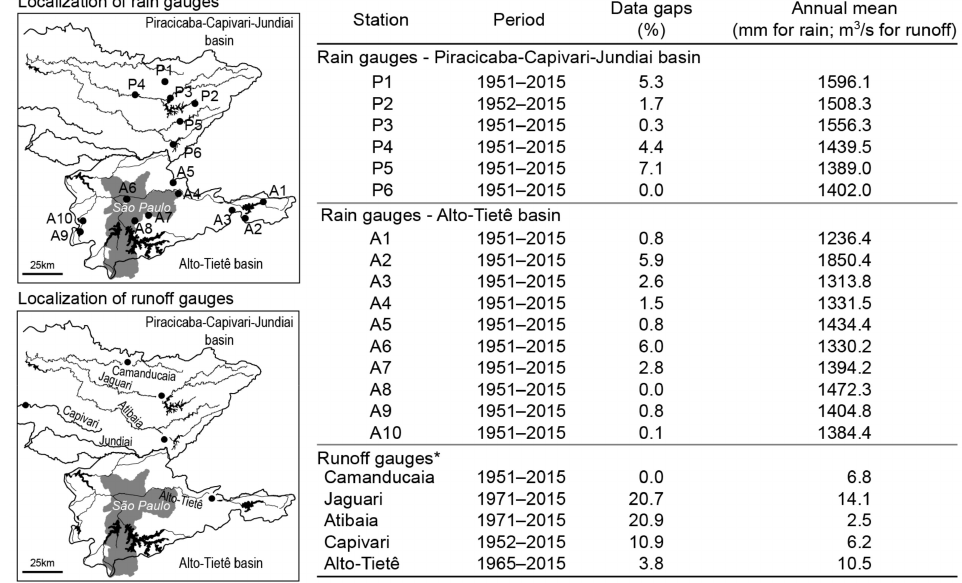
Figure 2. Dataset availability. * Data gaps and annual means are evaluated over the period for which data is